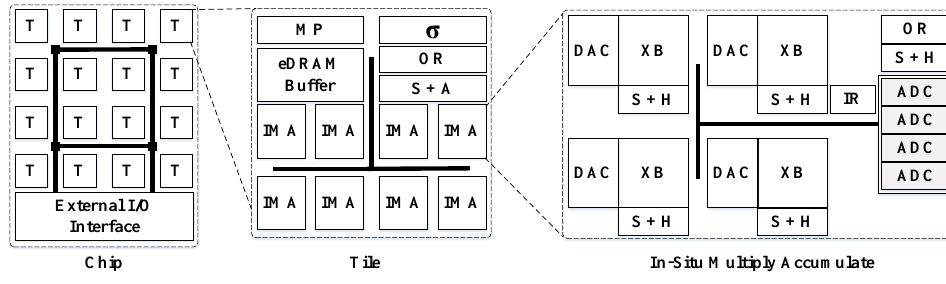
Figure 20. Overview of the ISAAC architecture (adapted from